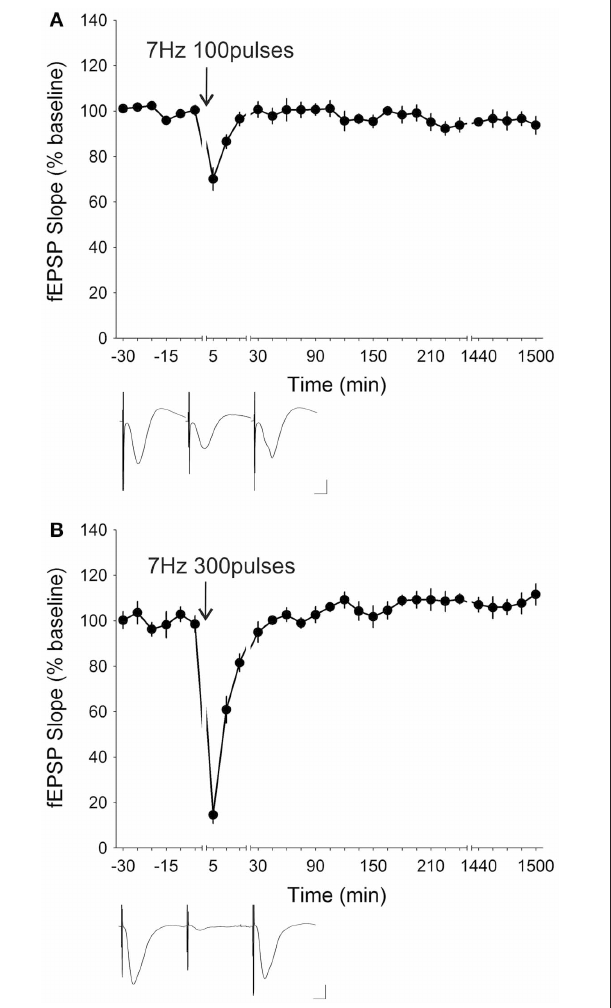
FIGURE 7 | Stimulation at 5Hz resulted in varying degrees of synaptic depression depending on stimulation the number of stimuli administered. (A) Low-frequency stimulation (LFS) at 5Hz with 300 stimuli induced short-term depression (STD) with an initial synaptic depression of 50 . 91 ± 6 . 10% that was significantly depressed for 15min post-stimulation (ANOVA, p = 0 . 41773; n = 5). (B) Increasing the number of stimuli at 5Hz to 900 pulses resulted in an attenuation of the initial synaptic depression (78 . 17 ± 12 . 38%) and reduction in the persistence of the synaptic depression to 10min (ANOVA, p = 0 . 25328; n = 7). Insets: analog traces illustrating the Schaffer collateral–CA1 field potentials at pre-stimulation, 5min and 24h (1440min). Vertical scale bar corresponds to 2mV and horizontal scale bar corresponds to 5ms.